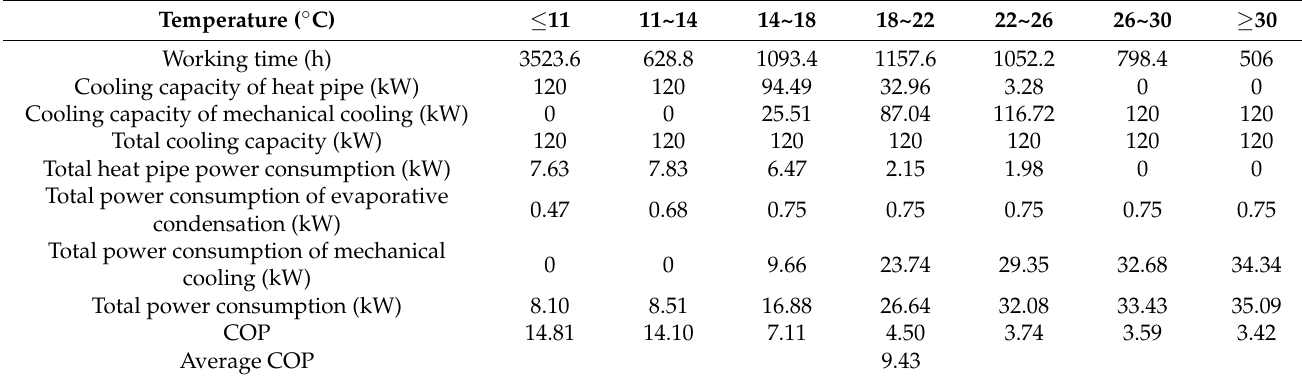
Table 9. Annual energy consumption for system.